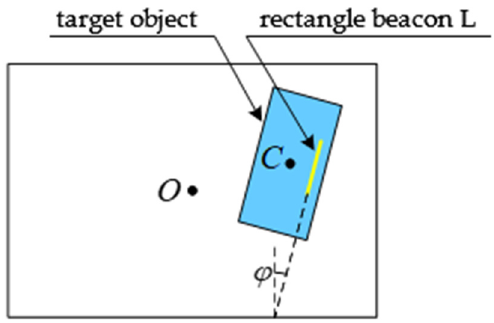
Figure 5. Camera projection image view as it rotates around the Y C and Z C axis. The angle of the projection line 𝐿 of the rectangular beacon in the pixel plane repre-